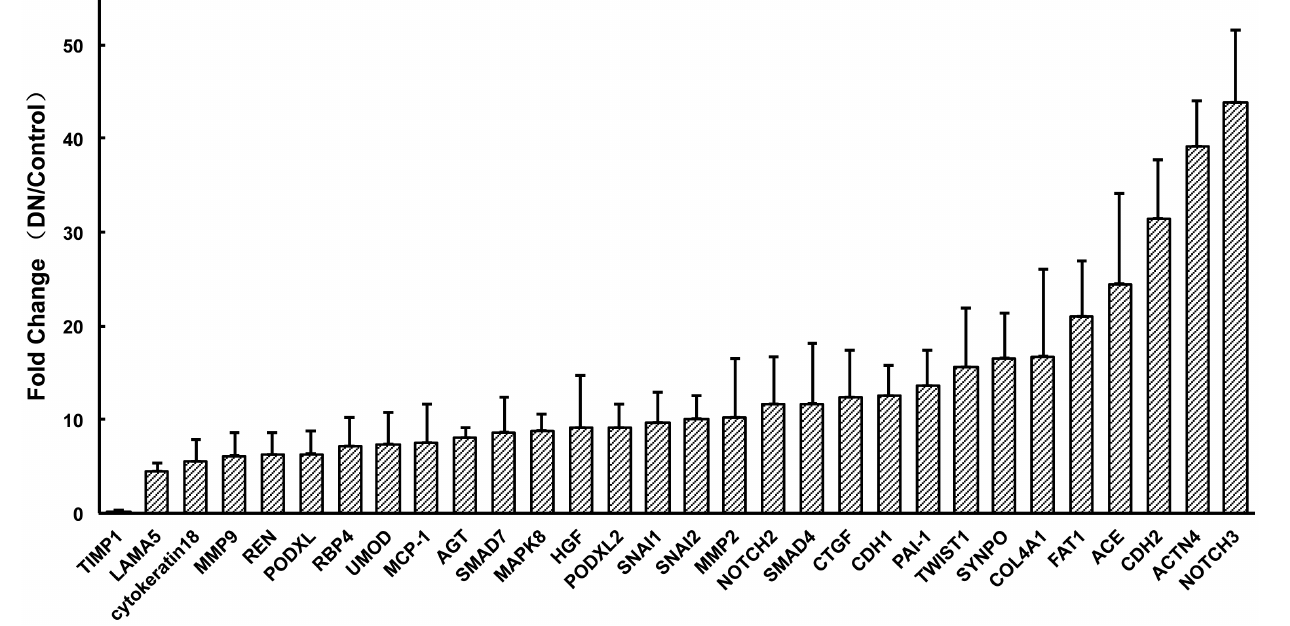
Figure 1. Fold change expressions of mRNAs between DN patients and controls. NOTCH3, ACTN4, CDH2, ACE, FAT1, COL4A1, SYNPO, TWIST1 were 15 fold increased and TIMP-1 was found with 15 fold decreased levels in DN group compared with normal controls.